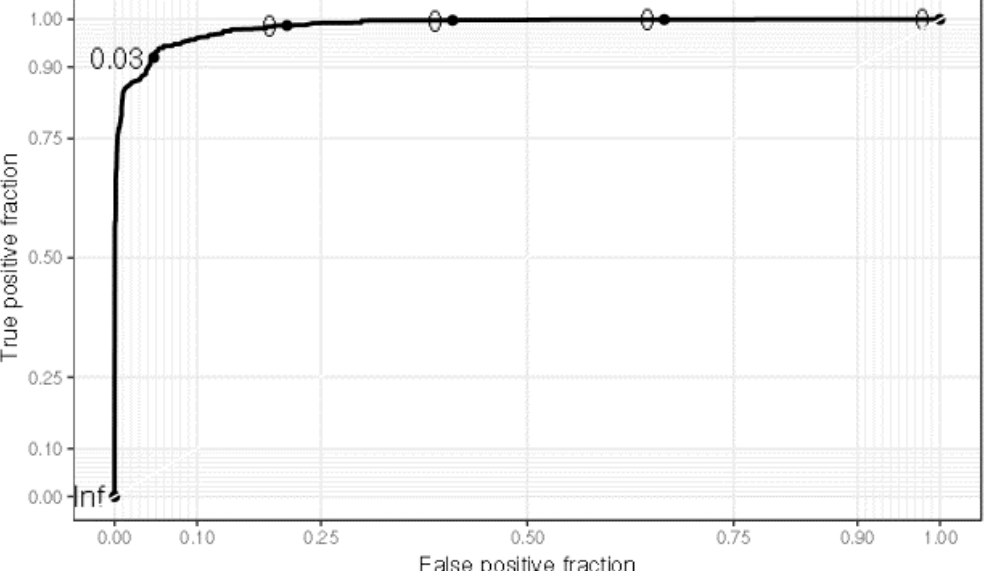
Figure 2. Month-level receiver operating characteristic (ROC) curve based on the test data set corresponding to the prediction model derived using the training data set. The area under the curve (AUC) is